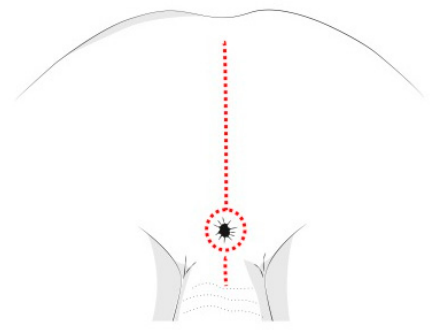
Figure 6. Posterior sagittal incision for pelvic NBs .